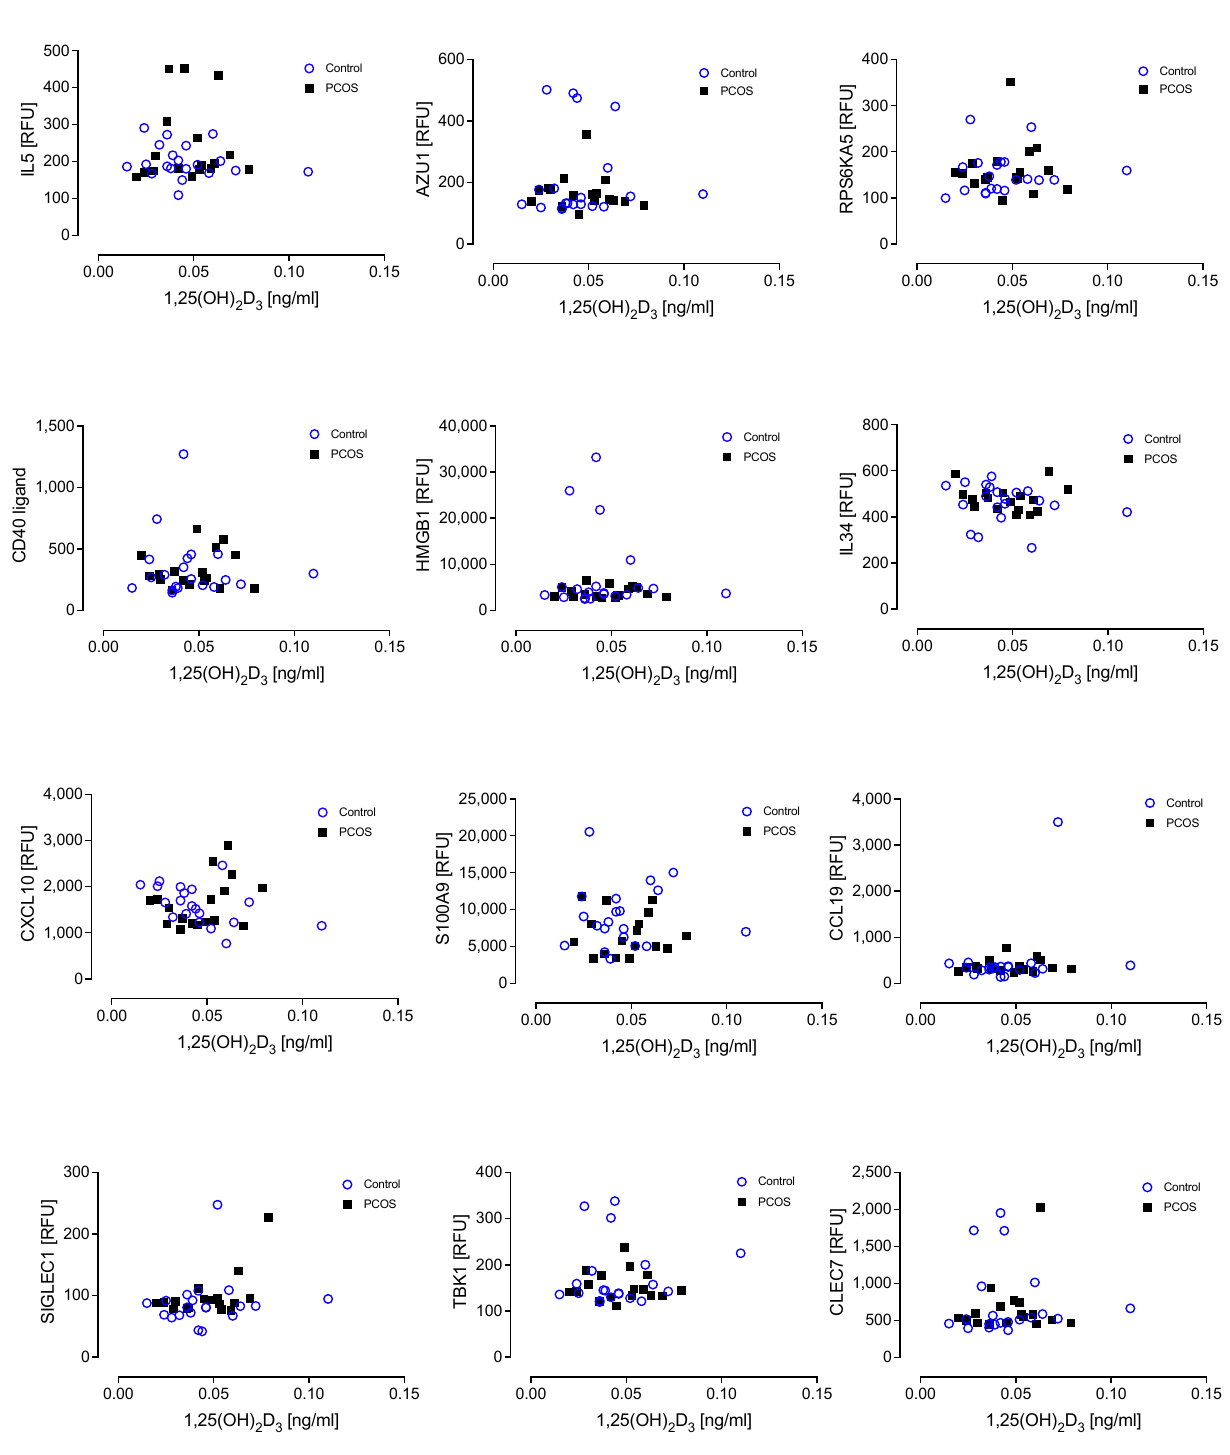
Figure 4. No relationship was found between 1,25(OH) 2 D 3 and the inflammatory markers Interleukin-5 (IL5), Azurocidin (AZU1), Ribosomal protein S6 kinase alpha-5 (RPS6KA5), CD40 ligand (CD40LG), High mobility group protein B1 (HMGB1), Interleukin-34 (IL34), C-X-C motif chemokine 10 (CXCL10), Protein S100-A9 (S100A9), C-C motif chemokine 19 (CCL19), Sialoadhesin (SIGLEC1), Serine/threonine-protein kinase (TBK1) and C-type lectin domain family 7 member A